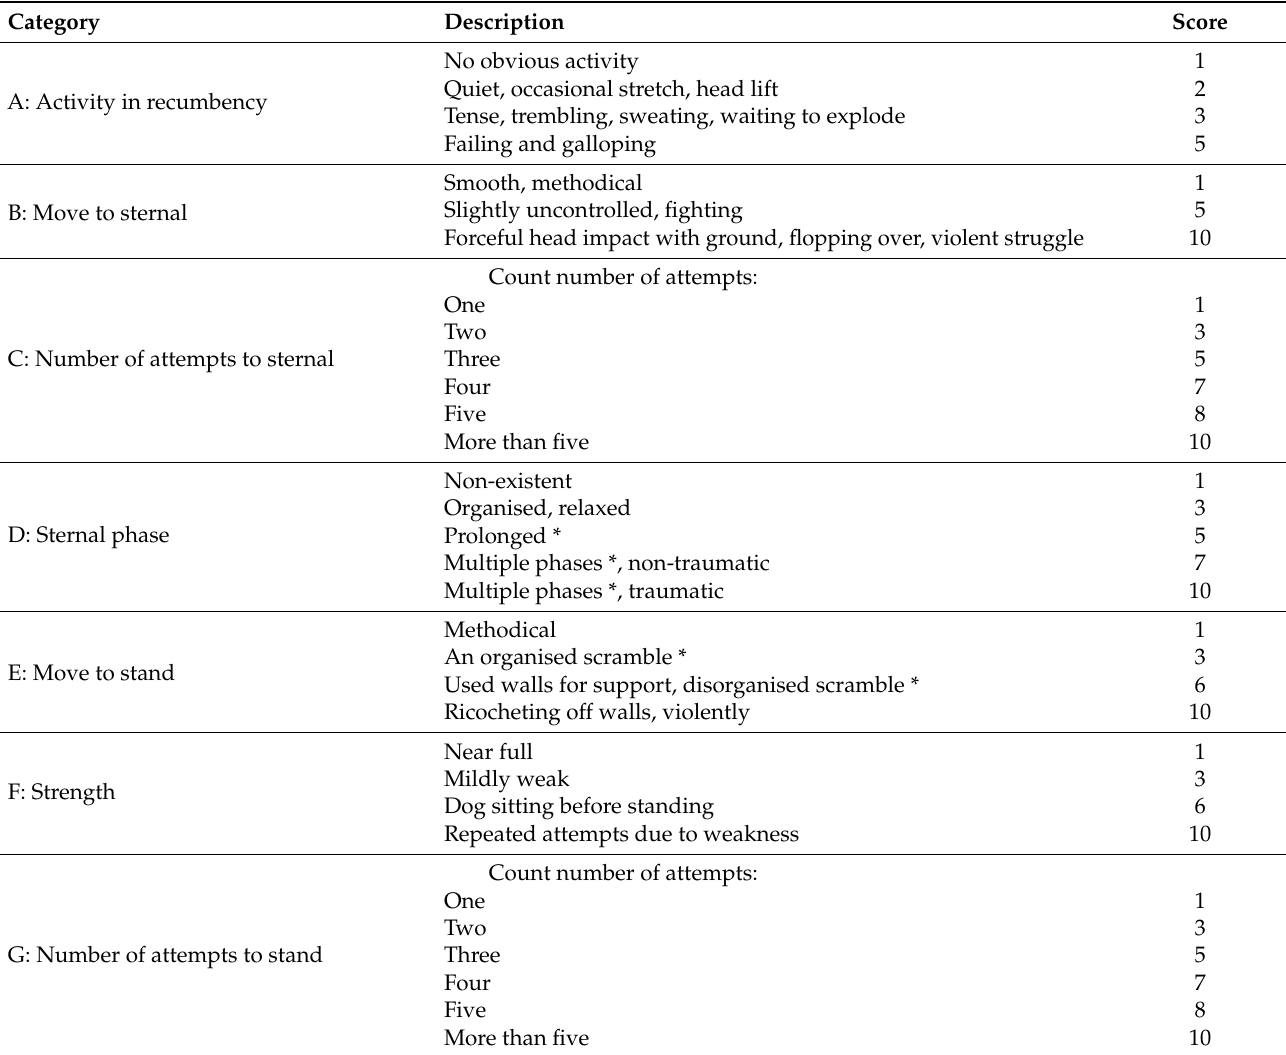
Table A1. Composite Scoring System